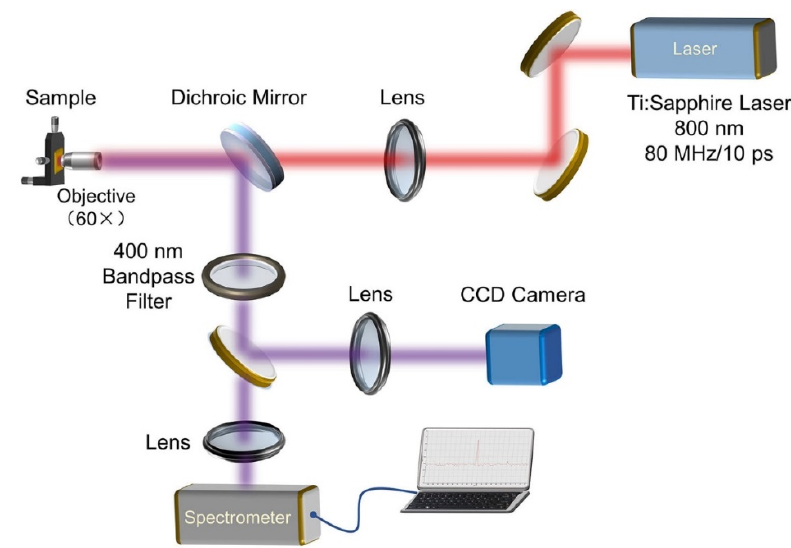
Figure 1. Experimental setup for the SHG measurement of ZnO nanofilms.